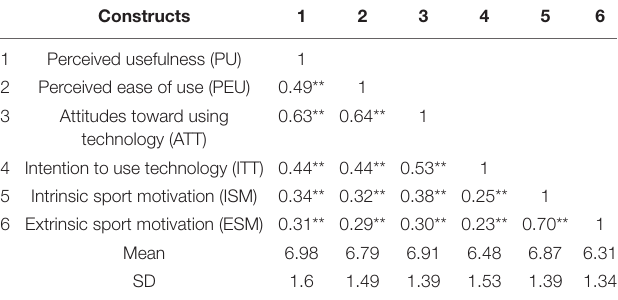
TABLE 1 | Means, standard deviations, and correlations of the constructs.